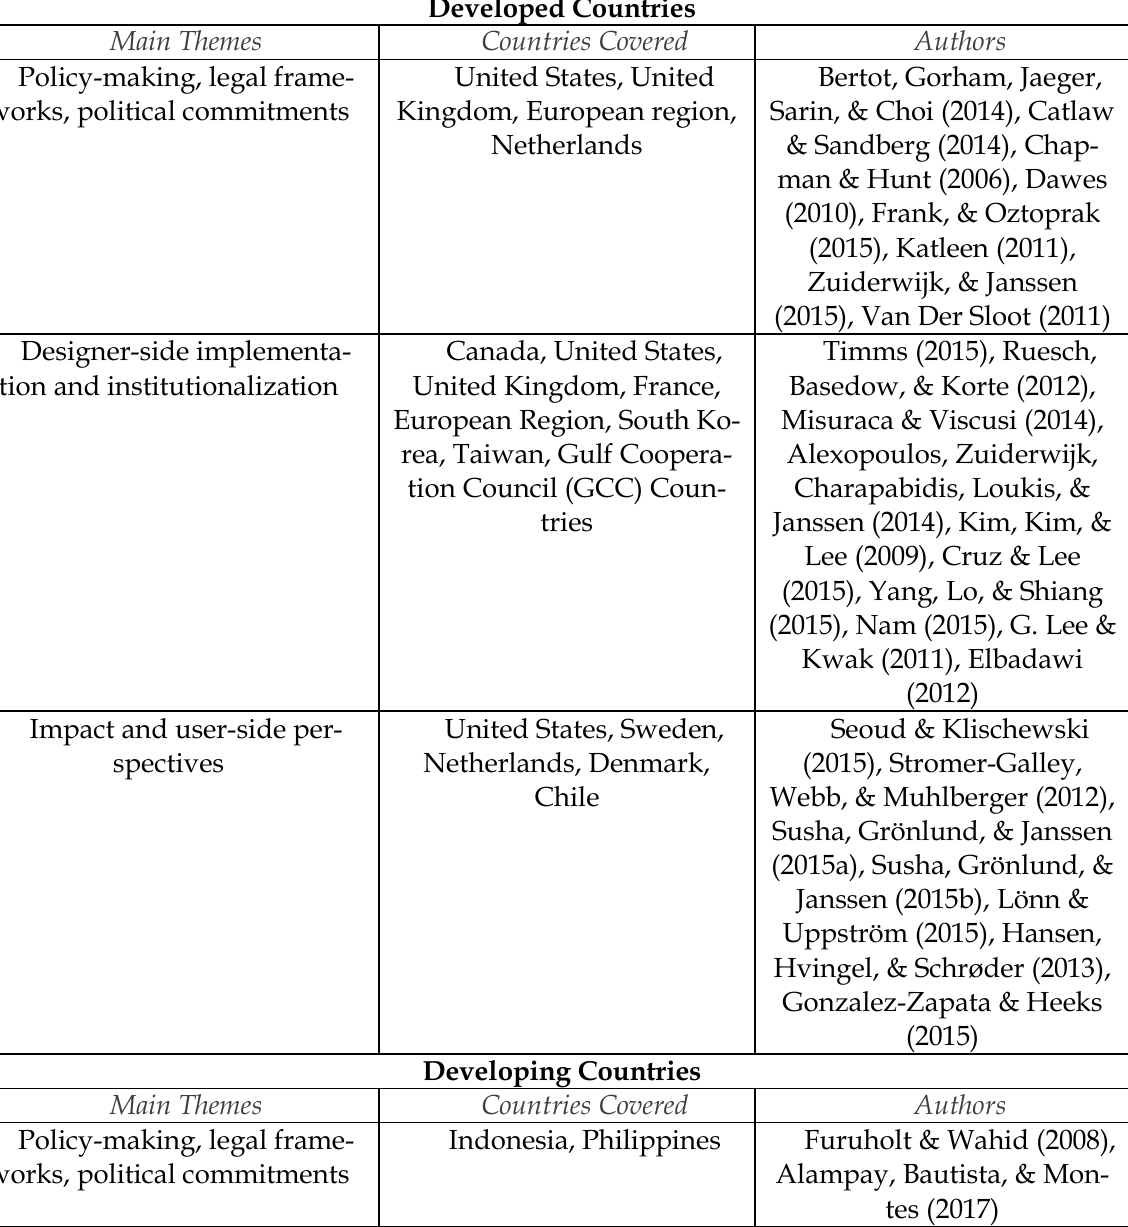
Table 1. Review of Open Government Literature and their Main